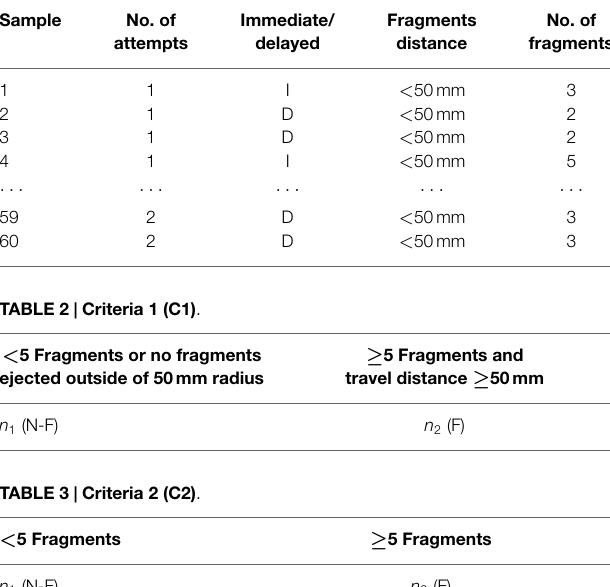
TABLE 1 | Example of collected raw data .